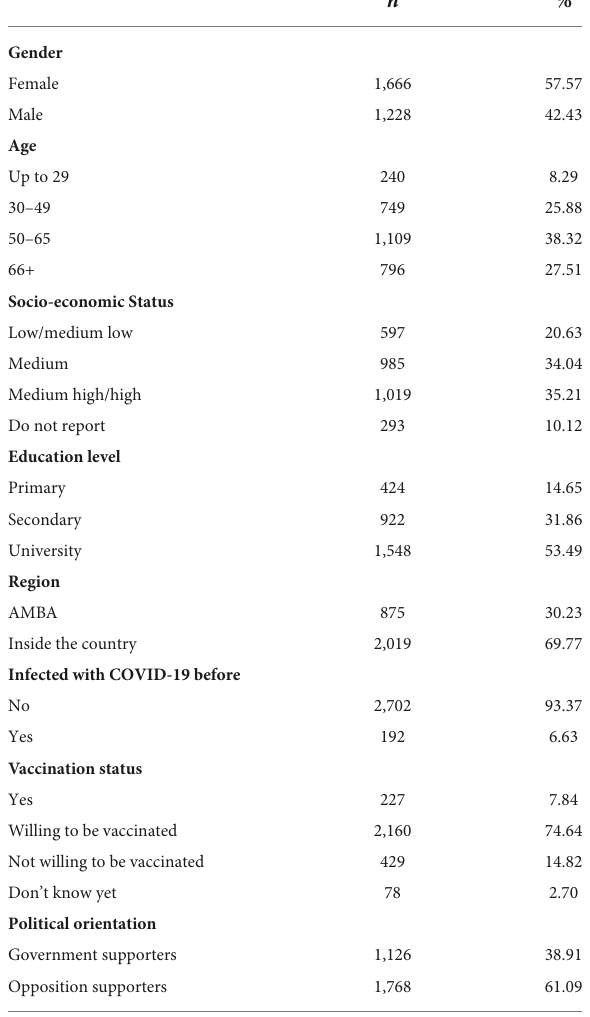
TABLE 1 Sociodemographic and descriptive data of the sample ( n =